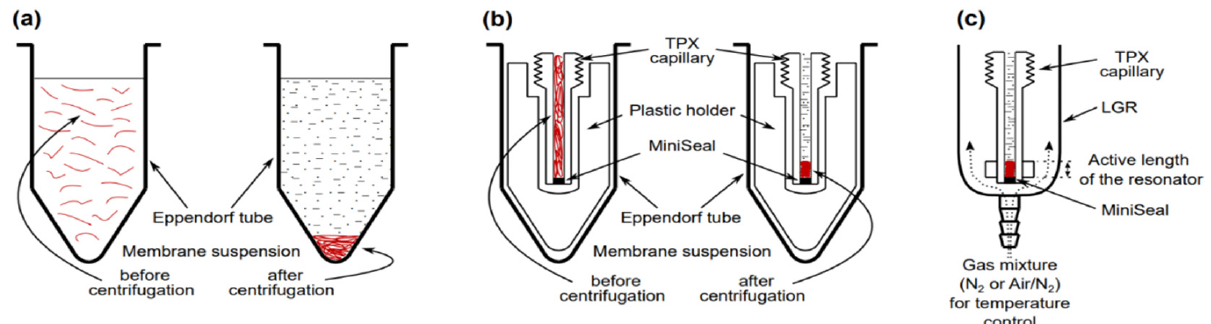
Figure 1. Schematic drawing showing the handling of samples with a small amount of a biological material for EPR measurements. ( a ) The first step: concentrating of the diluted sample by centrif- ugation in Eppendorf tubes to the volume of a TPX capillary. ( b ) The second step: further concen- trating the sample to match the sample length in the TPX capillary with the active length of the resonator. ( c ) The third step: positioning the TPX capillary inside the LGR with the sample located exactly in the active volume of the resonator. In the resonator, the sample can be equilibrated with the appropriate air/nitrogen